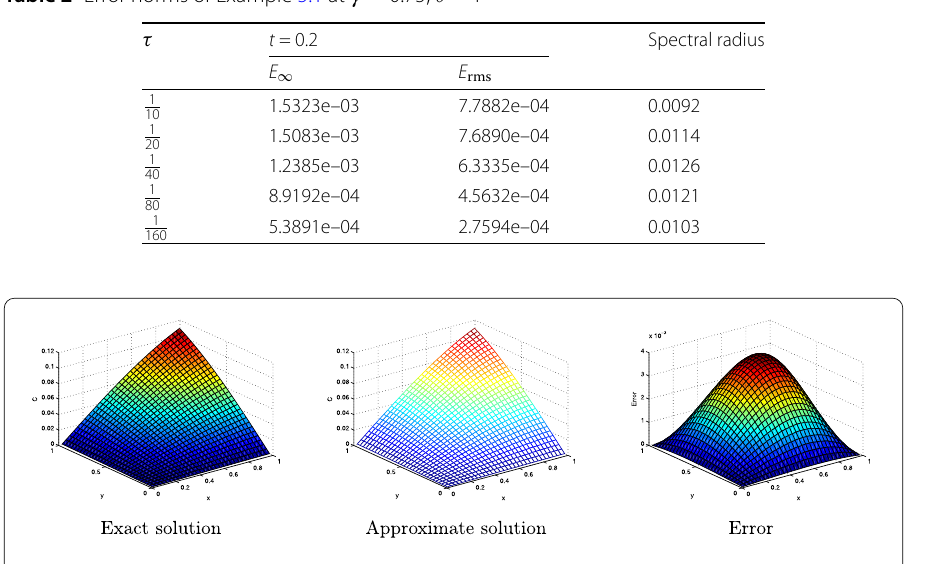
Figure 1 Graphical behavior of Example 5.1 when t = 0.4, γ =